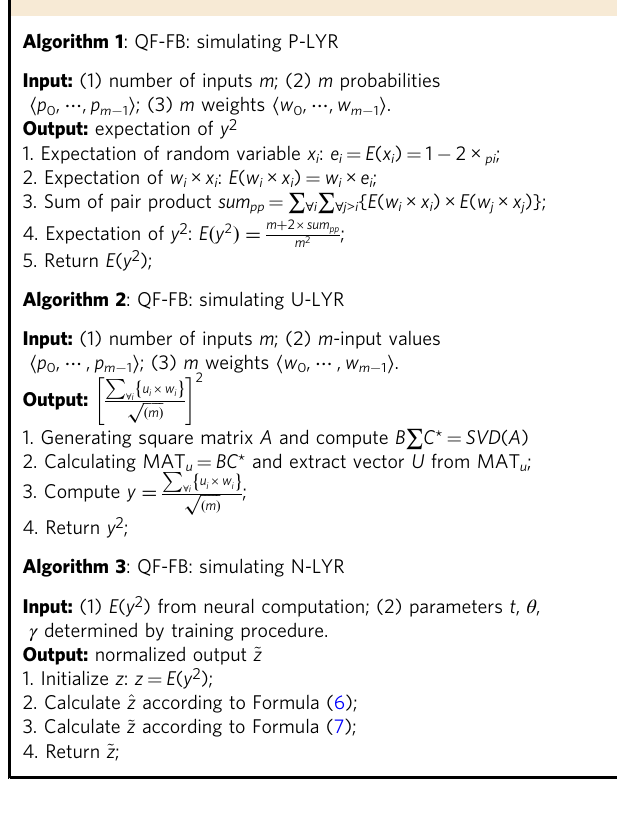
Algorithm 2 : QF-FB: simulating U-LYR